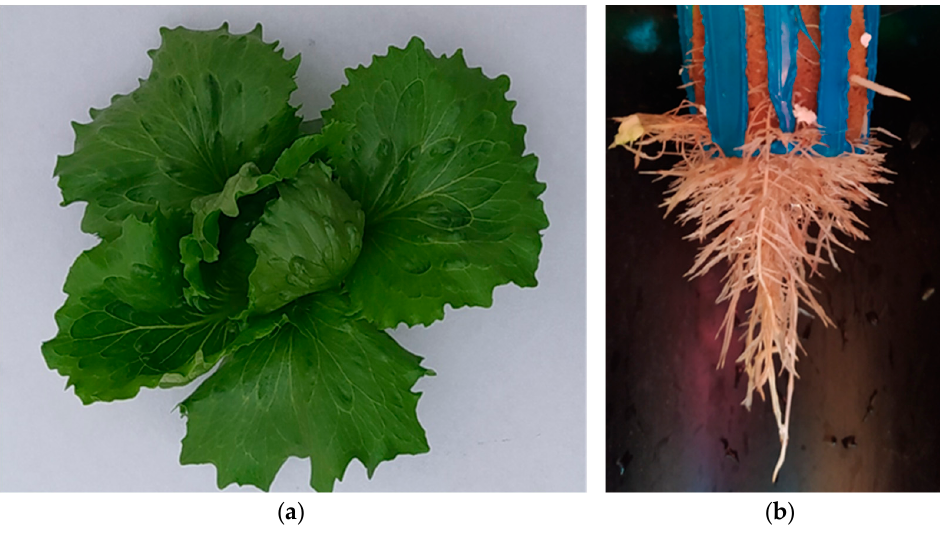
Figure 8. Crop 3 sample of ( a ) leaf and ( b ) root vegetative